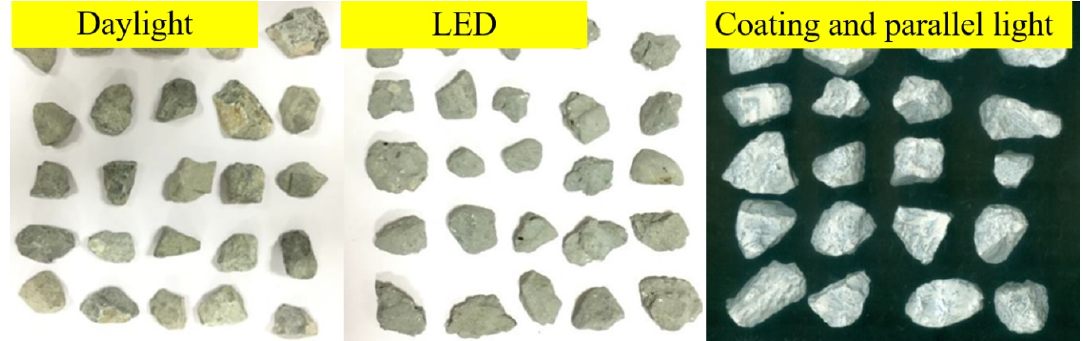
Figure 10. Surface image capture methods for recycled aggregates.